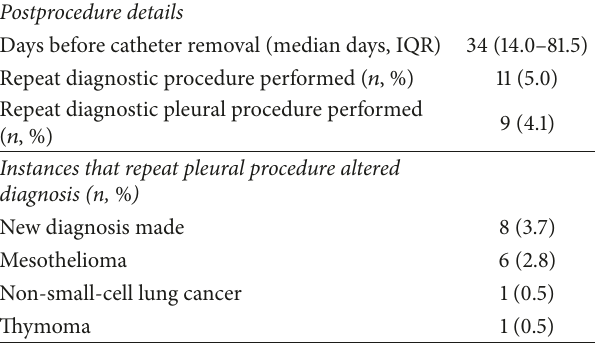
Table 5: Postprocedure details.